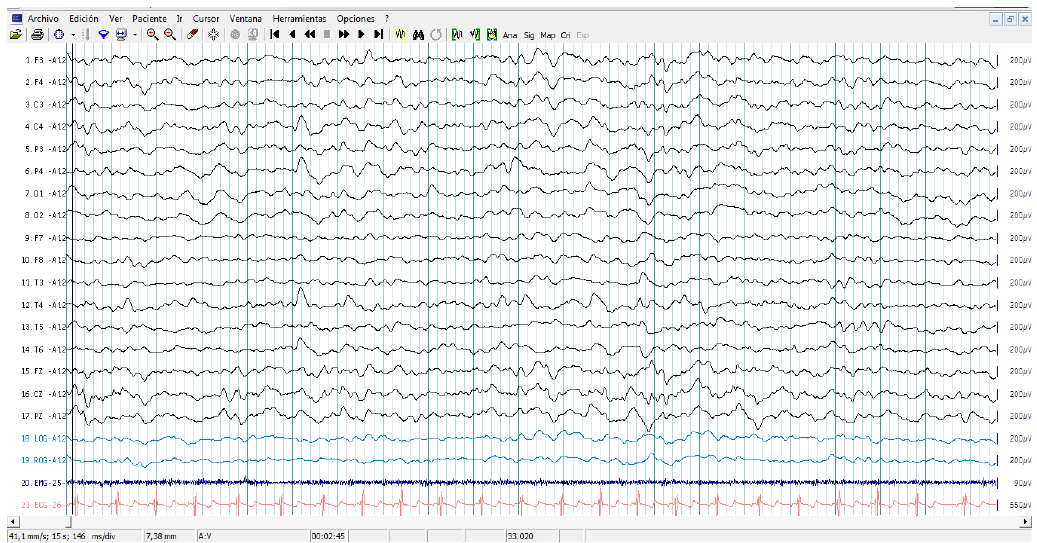
Figure 2. Sleep electroencephalography study in a patient with ASD without epileptic seizures. Recordings involve complete electroencephalogram, chin electromyography, eye movements, and electrocardiogram. Note EEG epileptiform abnormality in channels containing the right centro parieto-temporal leads, C4, P4, T4, and T6.